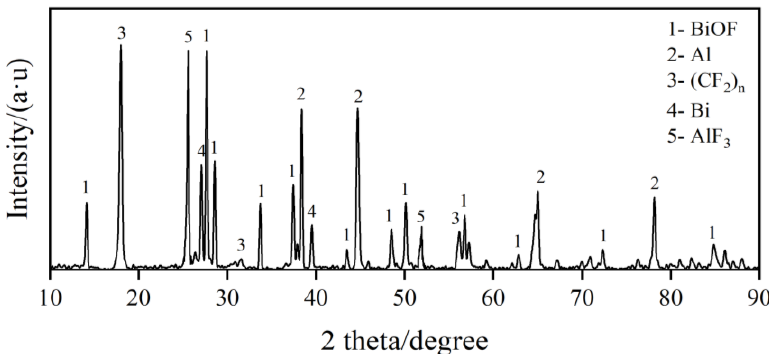
Figure 10. Micro-XRD of reacted zone.